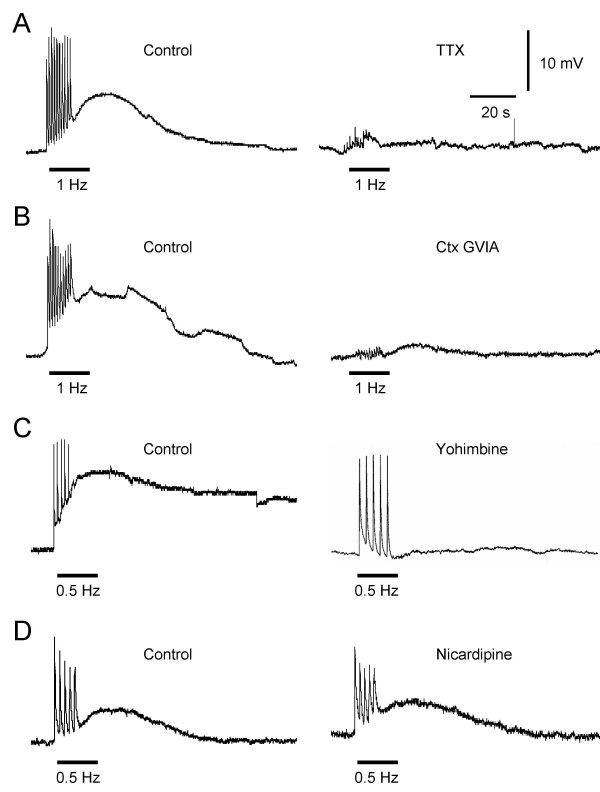
Tetrodotoxin (TTX), ω-conotoxin GVIA (Ctx GVIA) and yohimbine, but not nicardipine, inhibit the EFS-induces slow membrane depolarization of canine isolated mesenteric vein. Intracellular recordings of membrane potential in response to EFS (0.1 ms, 13 V, 10 s) in canine isolated mesenteric veins preincubated for 30 min prior to and throughout the experiment with 1 μM TTX (A), 5 nM ω-conotoxin GVIA (Ctx GVIA, B), 0.1 μM yohimbine (C) and 1 μM nicardipine (D). Scale bars apply to all traces.